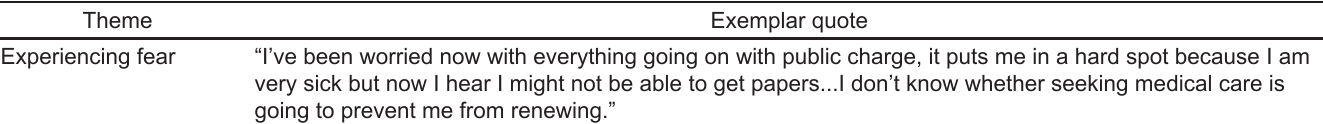
Table 2. Six themes with exemplar quotes from analysis of emergency department patient